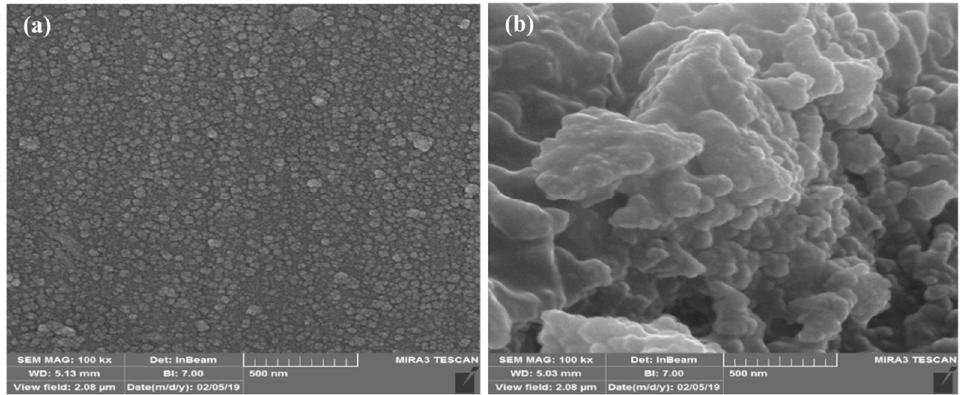
Figure 3. FE ‐ SEM results of drug ‐ loaded: ( a ) Stealth liposome and ( b ) liposome.